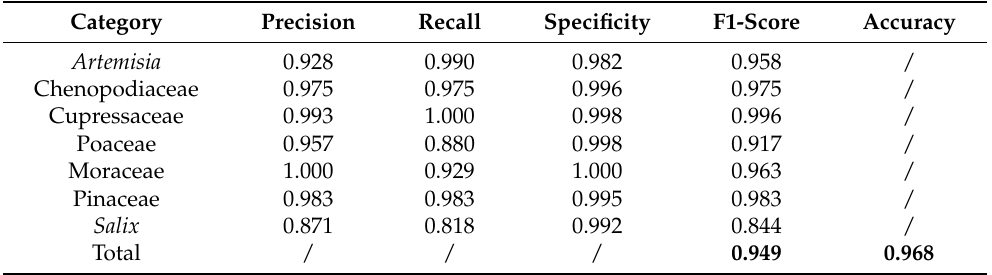
Table 5. The classification results for the multi-scale classifier with the VGG-19 backbone.